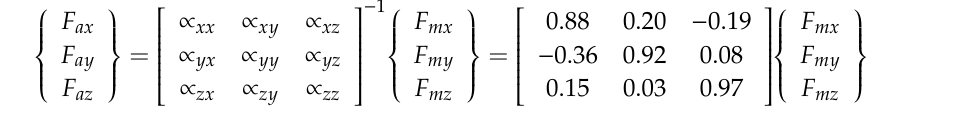
Table 2. Crosstalk Results from Finite Element (FE) Simulations.